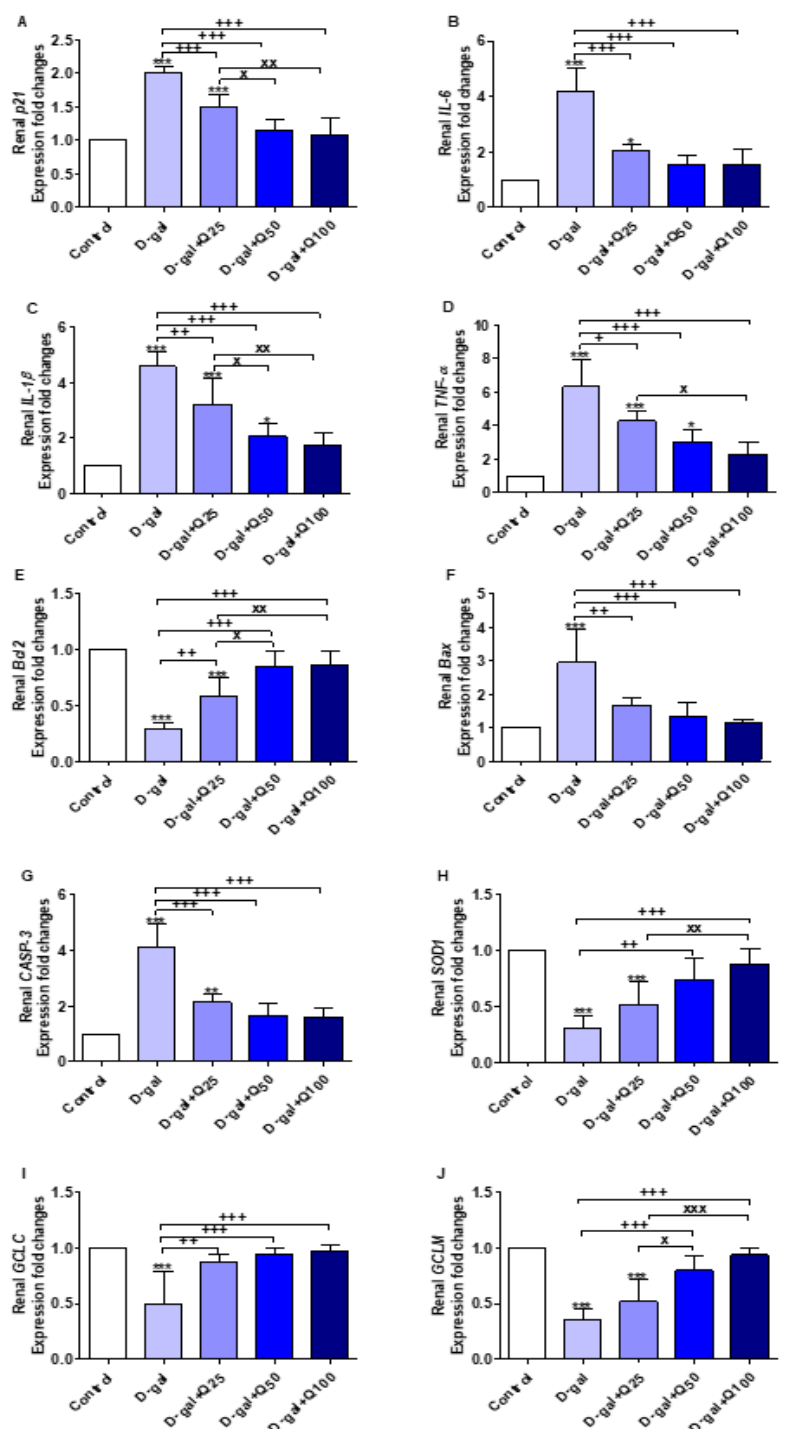
Figure 12. Expression of fold changes of renal ( A ) p21 , ( B ) interleukin-6 ( IL-6 ), ( C ) interleukin-1beta ( IL-1 β ), ( D ) tumor necrosis factor-alpha ( TNF- α ), ( E ) B-cell lymphoma 2 ( Bcl2 ), ( F ) Bcl-2-associated X protein ( Bax ), ( G ) caspase-3 ( CASP-3 ), ( H ) Cu, Zn-superoxide dismutase ( SOD1 ), ( I ) glutamate-cysteine ligase catalytic subunit ( GCLC ), and ( J ) glutamate-cysteine ligase regulatory subunit ( GCLM ) mRNA levels: Data were analyzed with one-way ANOVA followed by Tukey’s multiple comparison test. * p < 0.05, ** p < 0.01, and *** p < 0.001 vs. control. + p < 0.05, ++ p < 0.01, and +++ p < 0.001 vs. D-gal. x p < 0.05, xx p < 0.01, and xxx p < 0.001 vs. D-gal + Q25. Error bars represent mean ± SD. n =